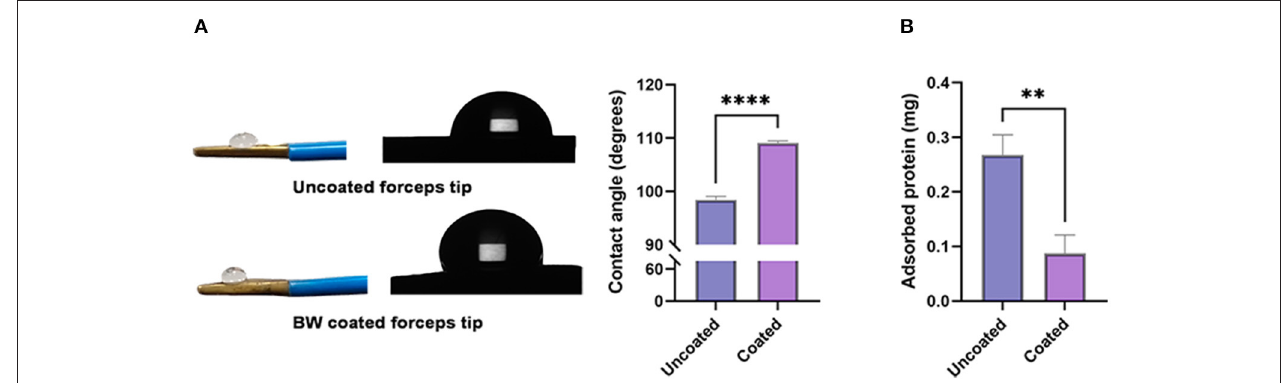
FIGURE 2 | Contact angle and electrocoagulation adherence of BW coated and uncoated tip. [ (A) -left] Photograph and schematic diagram of a 2 µ l water drop on BW coated and uncoated tips. [ (A) -right] Bar graph revealing the value of contact angle (degrees) ( n = 6). (B) Absorbed protein of BW coated and uncoated tips ( n